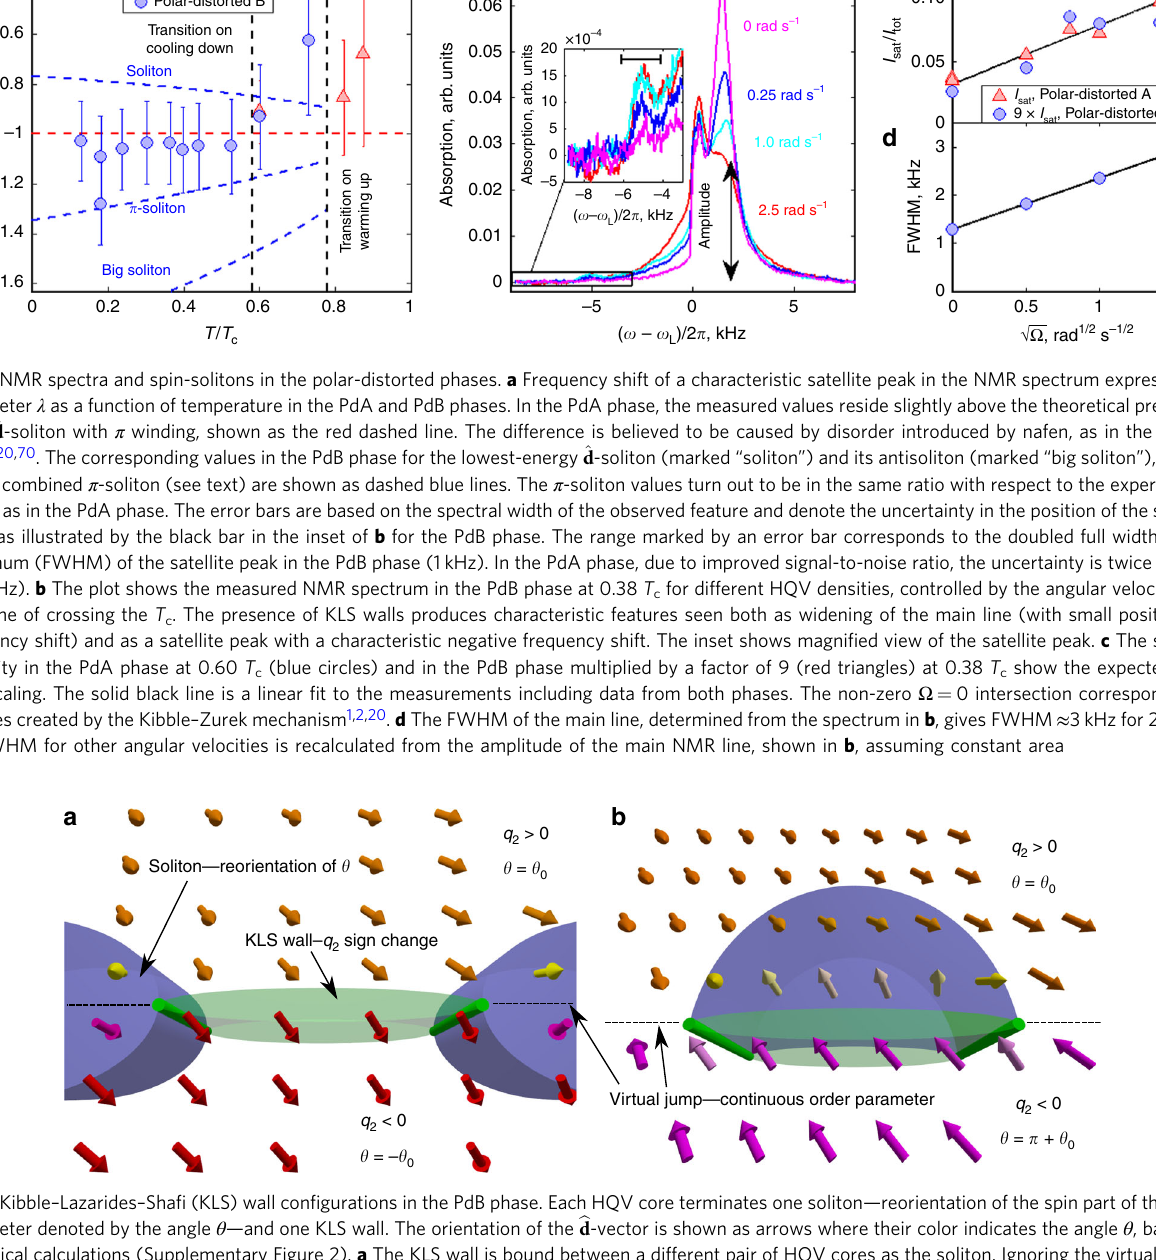
b d -vector is π across the ξ ≡ q − 1 ξ , where ξ is the coherence length, and the soliton has a W (cid:6) ξ . The soft core of the size of the dipole length ξ D W combination of these two objects may emerge in two different con fi gurations illustrated in Fig. 4. The minimization of the free energy (Supplementary Notes 2 and 3) shows that in the PdB phase, the lowest-energy spin-soliton corresponds to winding of b − 1 , on a cycle θ = q − 2 q d -vector by π − 2 θ the 0 , where sin 0 2 (2 1 ) around an HQV core. Additionally, the presence of KLS walls b d -vector by 2 θ results in winding of the 0 . These solitons can either extend between different pairs of HQVs, Fig. 4a, while walls with